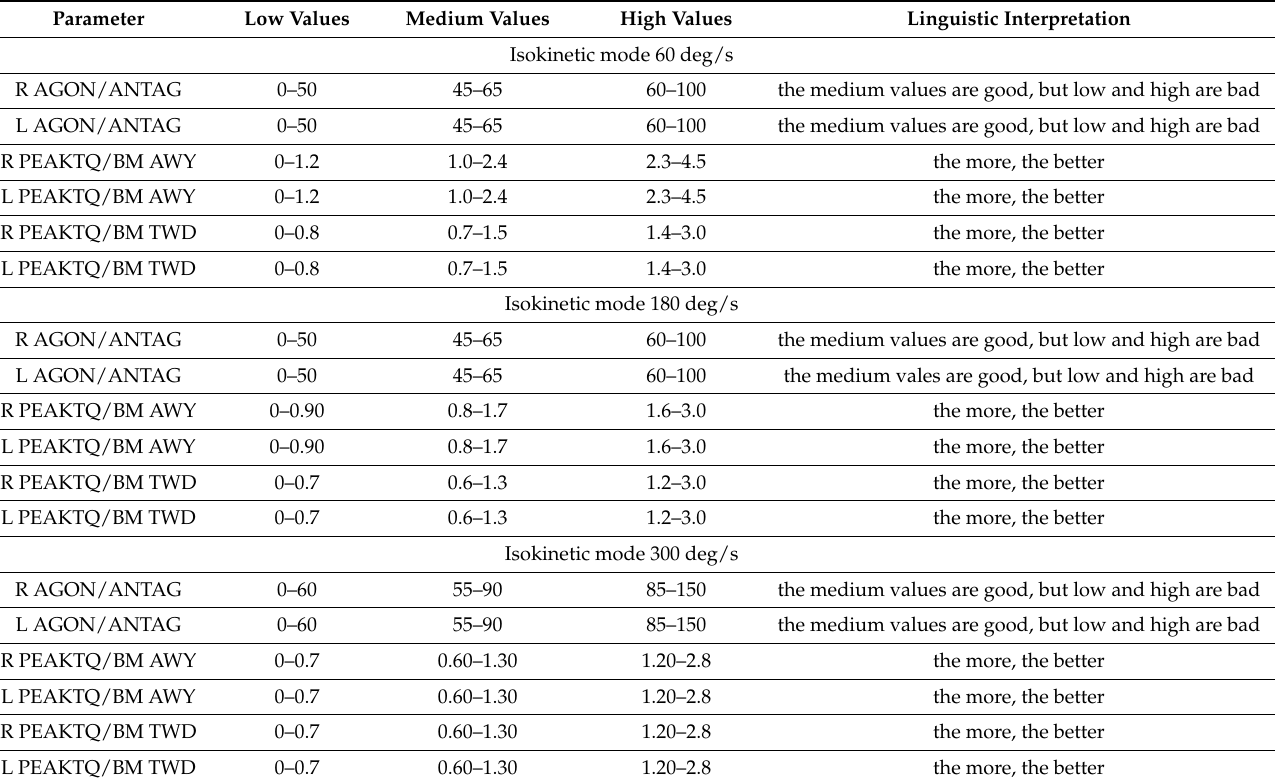
Table 2. The configuration of data intervals—base for the fuzzy system